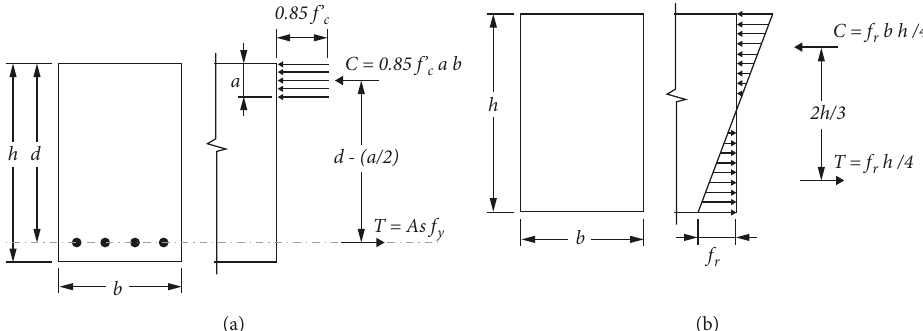
Figure 2: Flexural stress distribution of the beam. (a) Equivalent stress block for the reinforced beam and (b) elastic stress for the concrete beam before